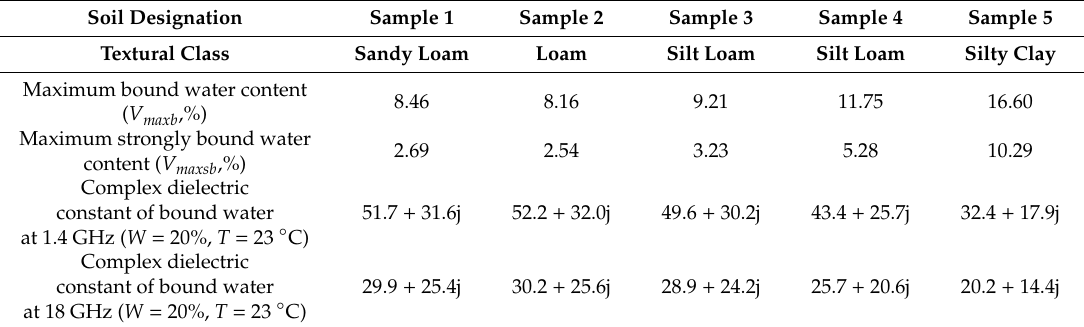
Table 2. Parameters and part results of complex dielectric constant model of bound